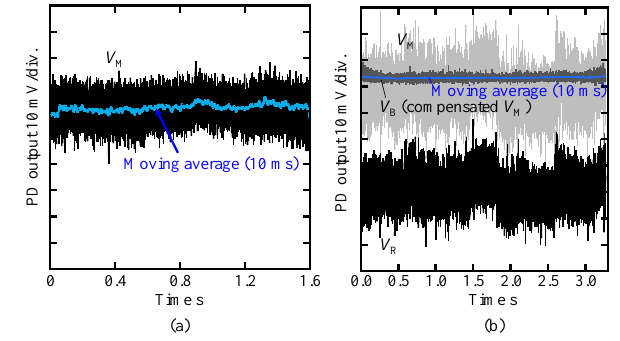
Figure 6. Stability of the PD outputs: (a) stability without compensation, (b) stability with compensation